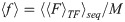
The free energy of nonconsensus TF-DNA binding negatively correlates with the combined TF occupancy for both C. elegans and D. melanogaster genomes.(a) The average free energy of nonconsensus TF-DNA binding per bp, 〈f〉=〈〈F〉TF〉seq/M (red), and the average, combined occupancy profile of 69 C. elegans TFs (blue), plotted around the TSSs of 17,207 C. elegans coding genes. The notation <TF occupancy> describes the average, combined occupancy profile of all 69 TFs. The linear correlation coefficient is computed for a linear fit of 〈f〉 versus <TF occupancy> at individual genomic locations, computed every 4 bp, within the interval (-1500,1500) around the TSS. The sequences are aligned with respect to the TSS. In order to compute error bars, we divided genes into ten randomly chosen subgroups, and computed 〈f〉 for each subgroup. The error bars are defined as one standard deviation of 〈f〉 between the subgroups. The error bars for the combined TF occupancy are computed analogously. (b) Correlation between the minimum value of the free energy of nonconsensus TF-DNA binding, f
min = min(f), and the combined occupancy of all TFs, computed for individual genes in non-overlapping windows of 100 bp, within the entire interval (-1000,1000). The data was grouped into 50 bins. (c) Similar to (a) but showing the average free energy of nonconsensus TF-DNA binding per bp, 〈f〉 (red), and the average transcription factor occupancy (blue), around the TSSs of 12,188 D. melanogaster genes. (d) Similar to (b) but for 12,188 D. melanogaster genes.